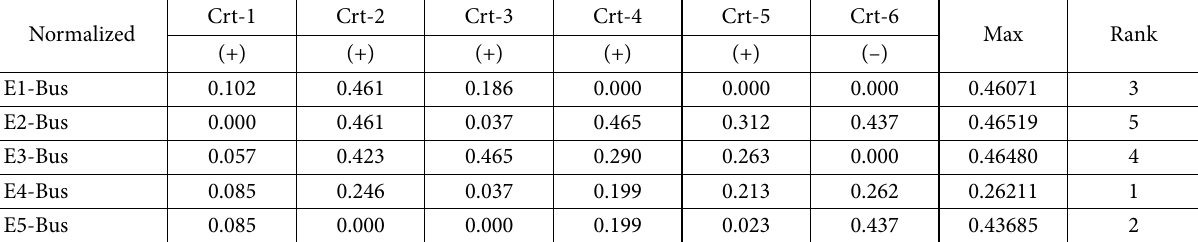
Table 5. Reference point approach and ranking